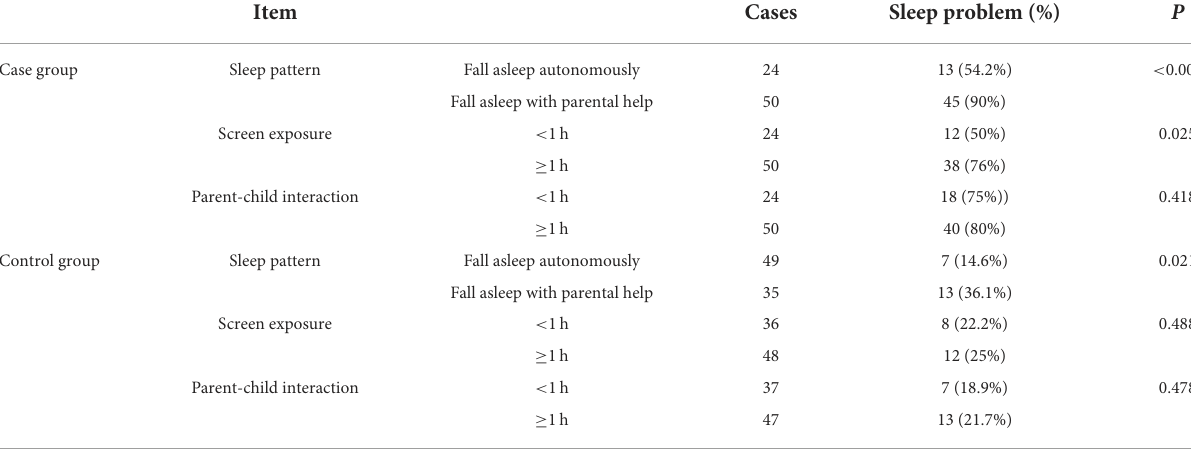
TABLE 5 Comparison of the incidence of sleep problems between the two groups of children under different sleep behaviors and screen exposure. Item Cases Sleep problem